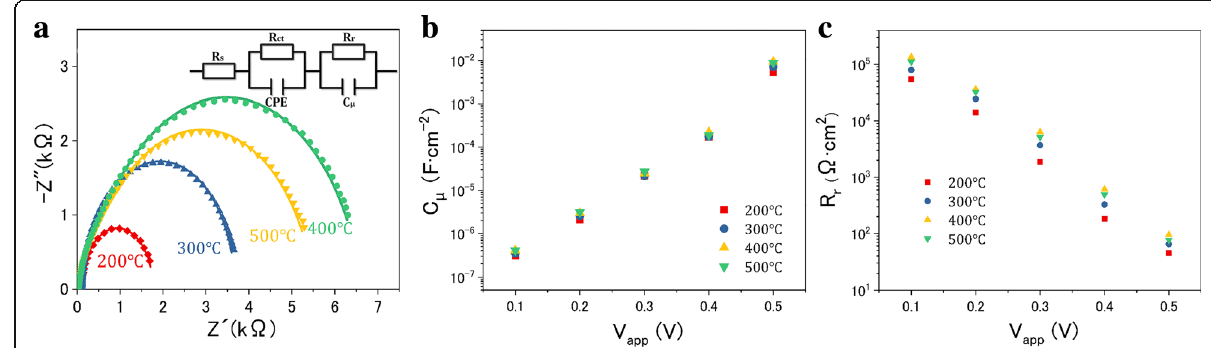
Fig. 7 a EIS spectra of the cell devices measured in the dark at − 0.4 V bias. The inset in a illustrates the equivalent circuit simulated to fit the impedance spectra. R S represents the substrate resistance. R ct and CPE represent the charge transfer resistance and capacitance at the HTM/ counter electrode interface, respectively. R r and C μ represent the recombination resistance and chemical capacitance at the photoelectrode/HTM interface, respectively. b C μ and c R r at different applied voltages (V app ), calculated from the fitting of the impedance spectra